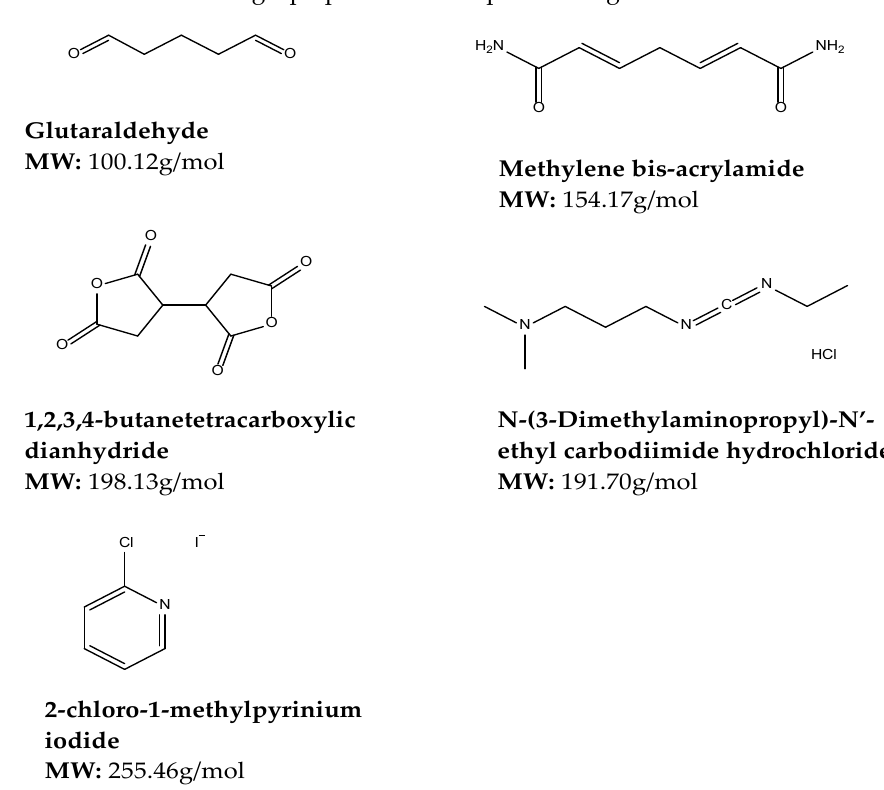
Figure 6. Chemical structures and molecular weights (MW) of various synthetic crosslinkers used to manufacture cross-linked gels.